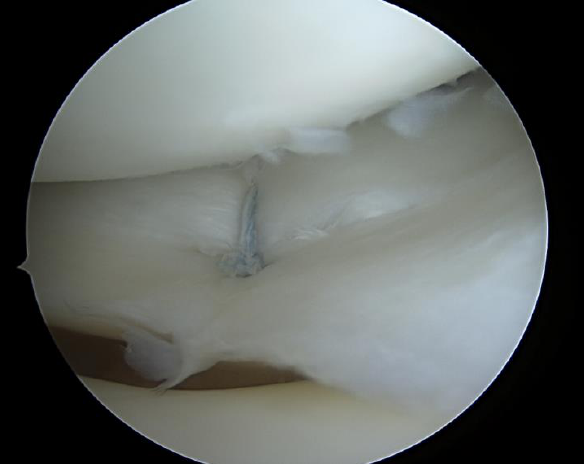
Figure 2. Arthroscopic image demonstrating an all-inside meniscal repair of medial meniscus.